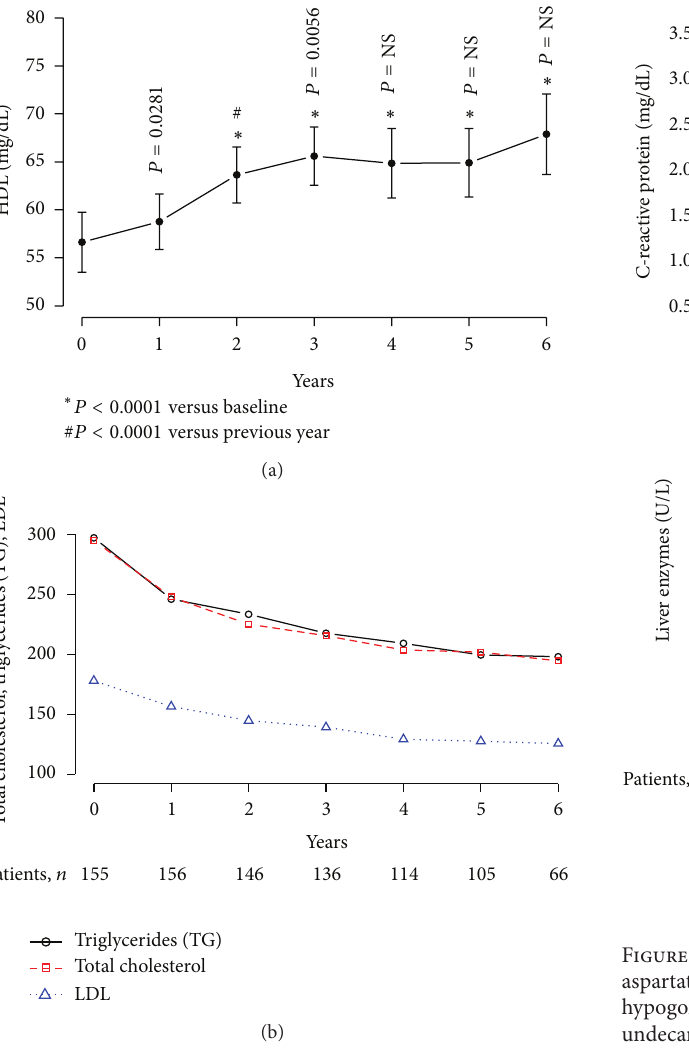
Figure 9: Changes in lipids (mg/dL) in 156 obese hypogonadal men with type 2 diabetes treated with testosterone undecanoate injections for up to 6 years. HDL cholesterol (a). Total cholesterol, LDL cholesterol, and triglycerides (b).